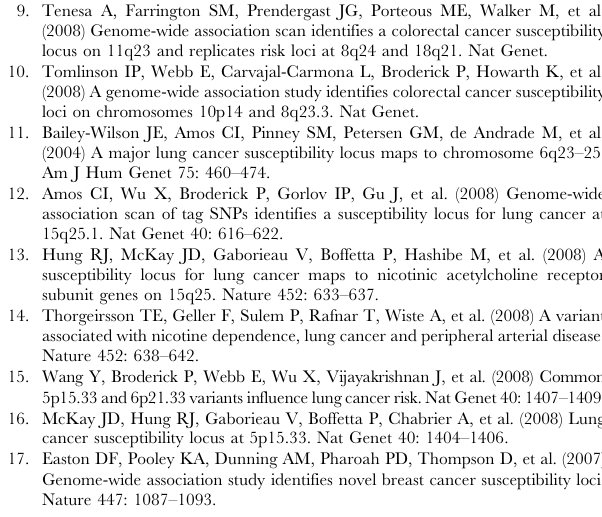
Figure S1 Supplementary Figure